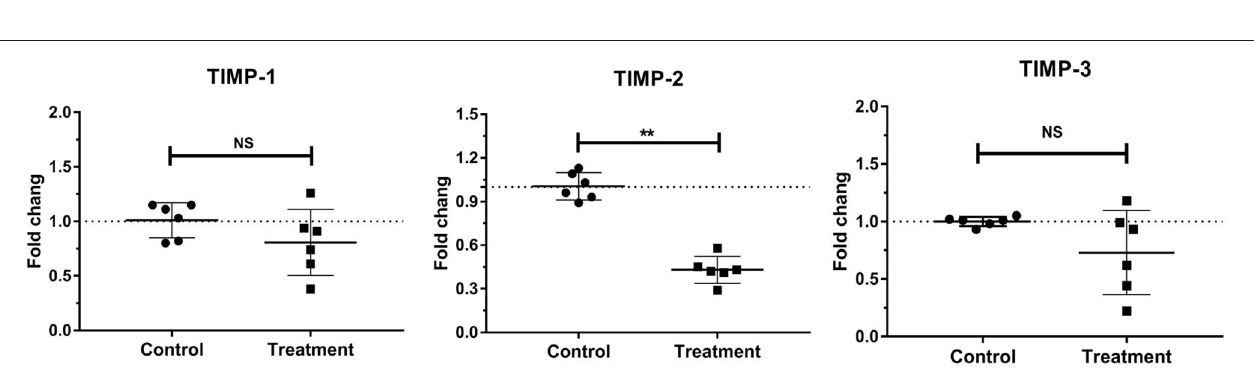
we can reasonably speculate that disordered proteolytic events involving MPs and other components may occur in the progression of bovine